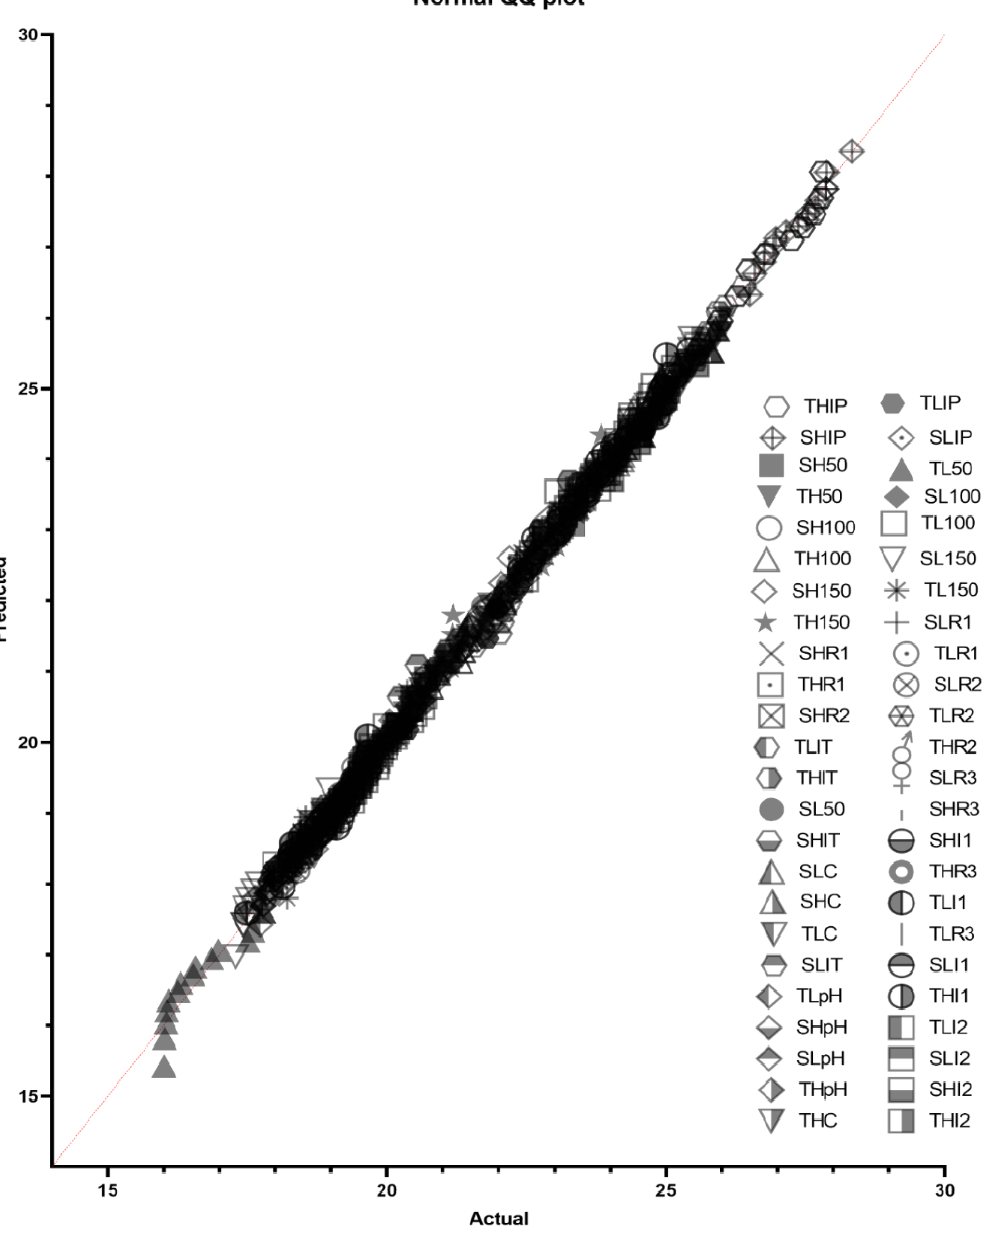
Figure 5. Q-Q plot for normality of all test groups in the validation study showing the predicted values against the actual data obtained from the experiment (red line is the ideal relationship): S: Standard, T: Test, H: High dose, L: Low dose, R: Repeatability, I: intermediate precision, IP: Incubation Period, IT: Incubation Temperature, 50: 50% accuracy test, 100: 100% accuracy test and 150: 150% accuracy